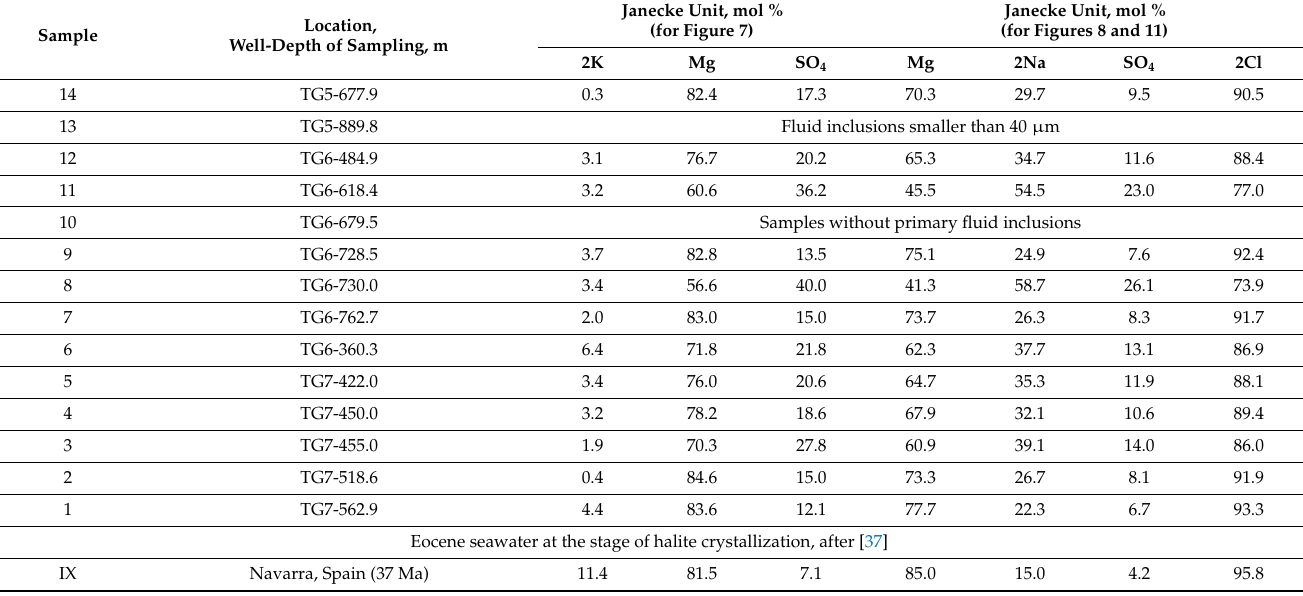
Table 2. Chemical composition of Tuz Gölü brines, and Cenozoic marine brines in Jenecke